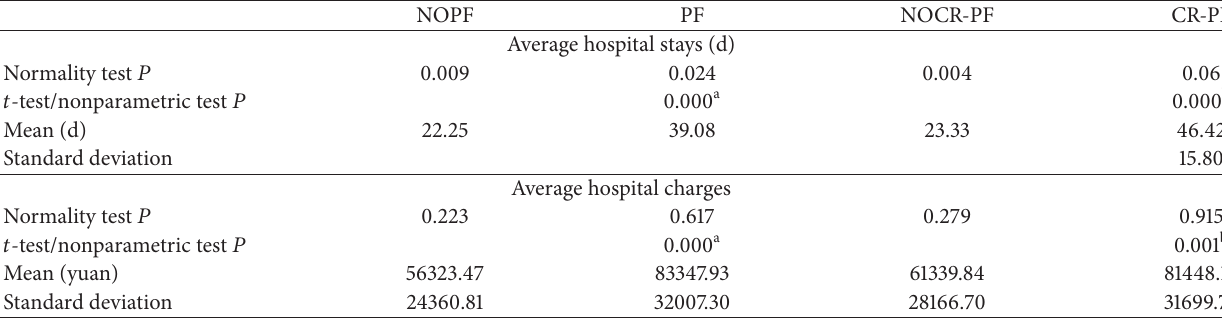
Table 4: Hospital charges and hospital